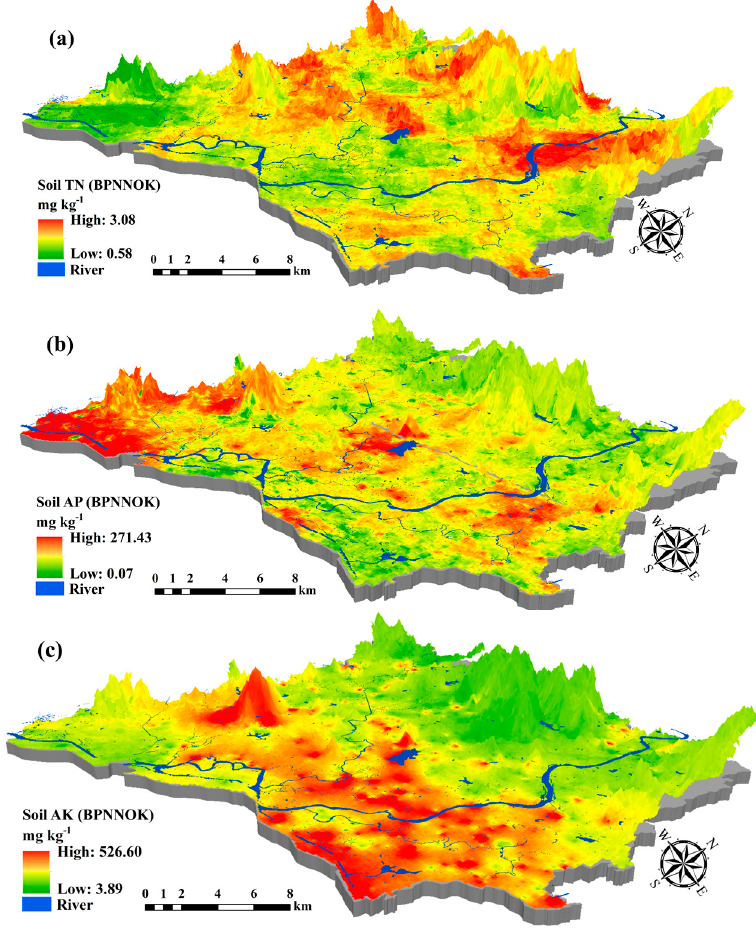
Figure 5. Measured values versus estimated values of ( a ) soil TN; ( b ) soil AP; and ( c ) soil AK, using BPNNOK model.